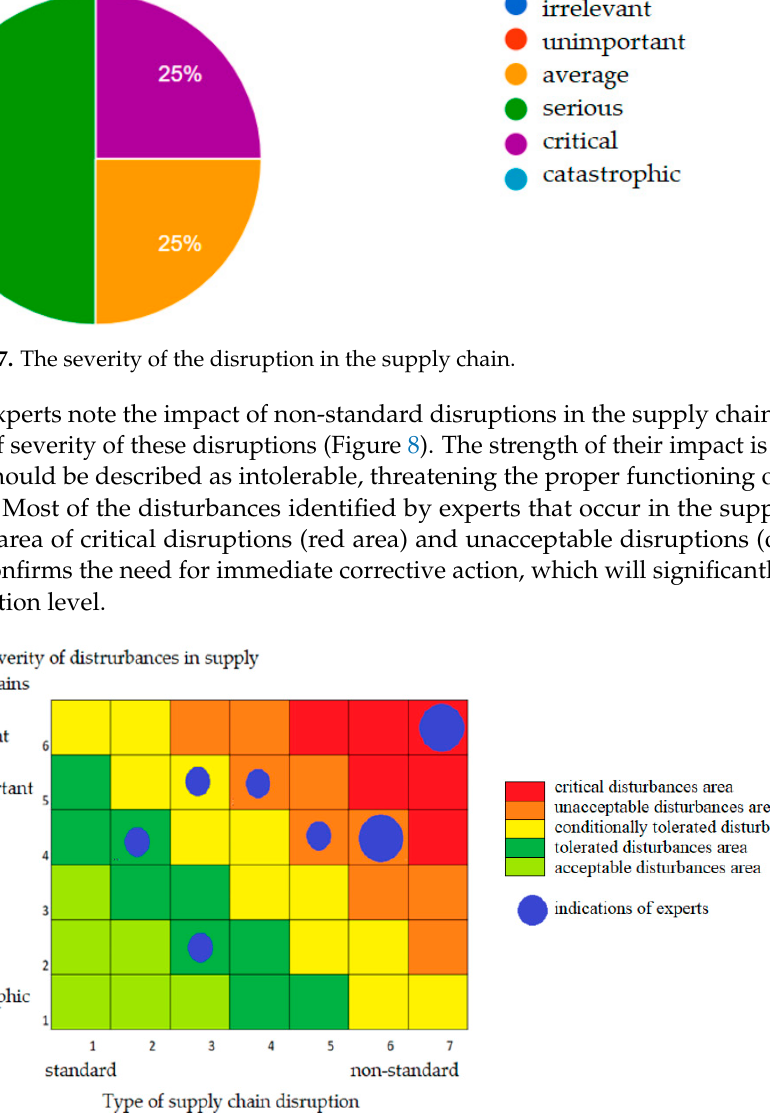
Figure 8. Impact of the type of disturbance on the severity of the disturbance in the supply chain.